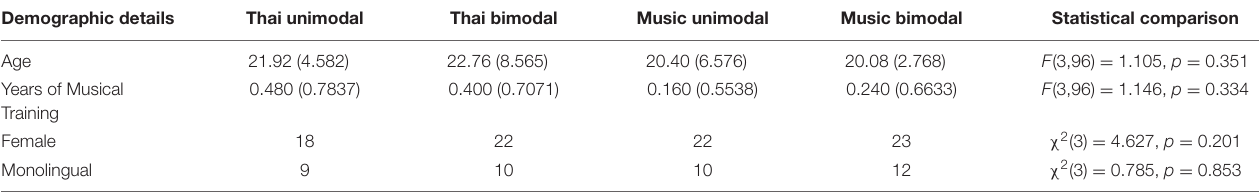
TABLE 1 | Demographic details of the four groups in this